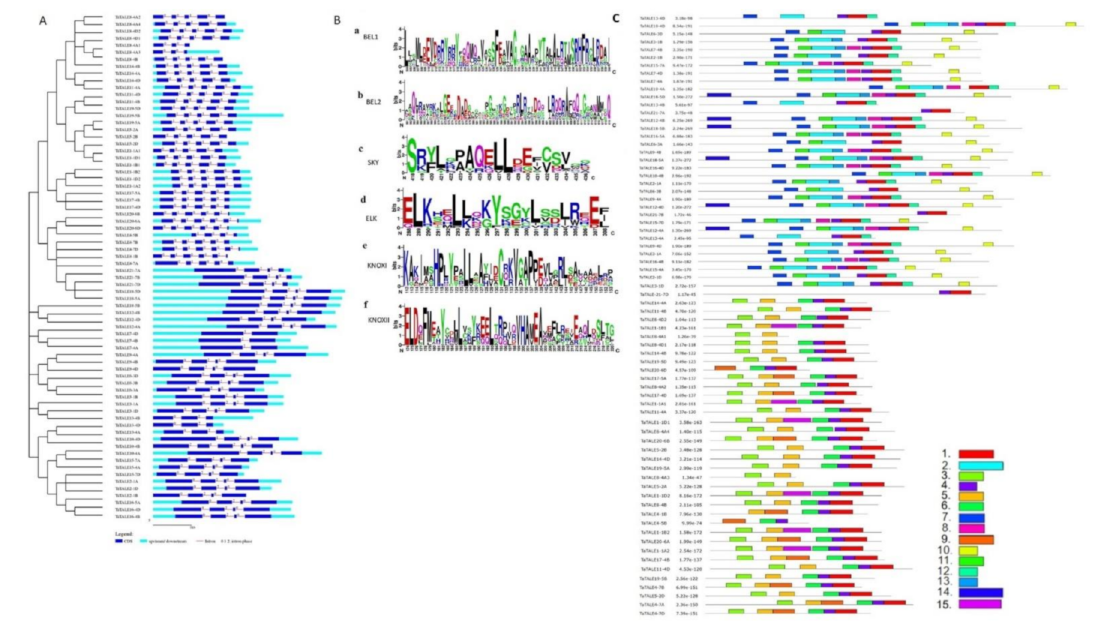
Figure 3. Exon-intron, domain, and motif analysis. ( A ) Exon-intron organization of TaTALE genes generated using the GSDS 2.0. server. ( B ) WebLogo analysis of conserved domains; ( a ) BELL1, ( b ) BELL2, ( c ) SKY in TaBLH class, and ( d ) ELK, ( e ) KNOXI, and ( f ) KNOXII of the TaKNOX class of TaTALE proteins. ( C ) Distribution of 15 conserved motifs in TaTALE proteins constructed by the MEME